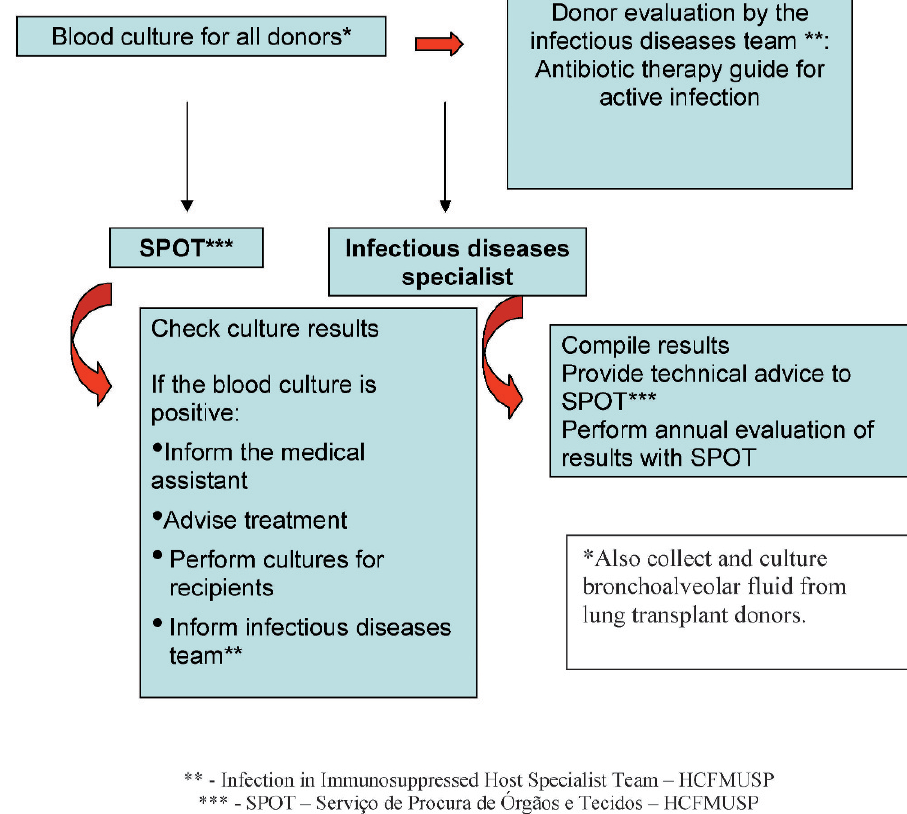
Figure 1 - Evaluation of Bacterial Infection in Organ